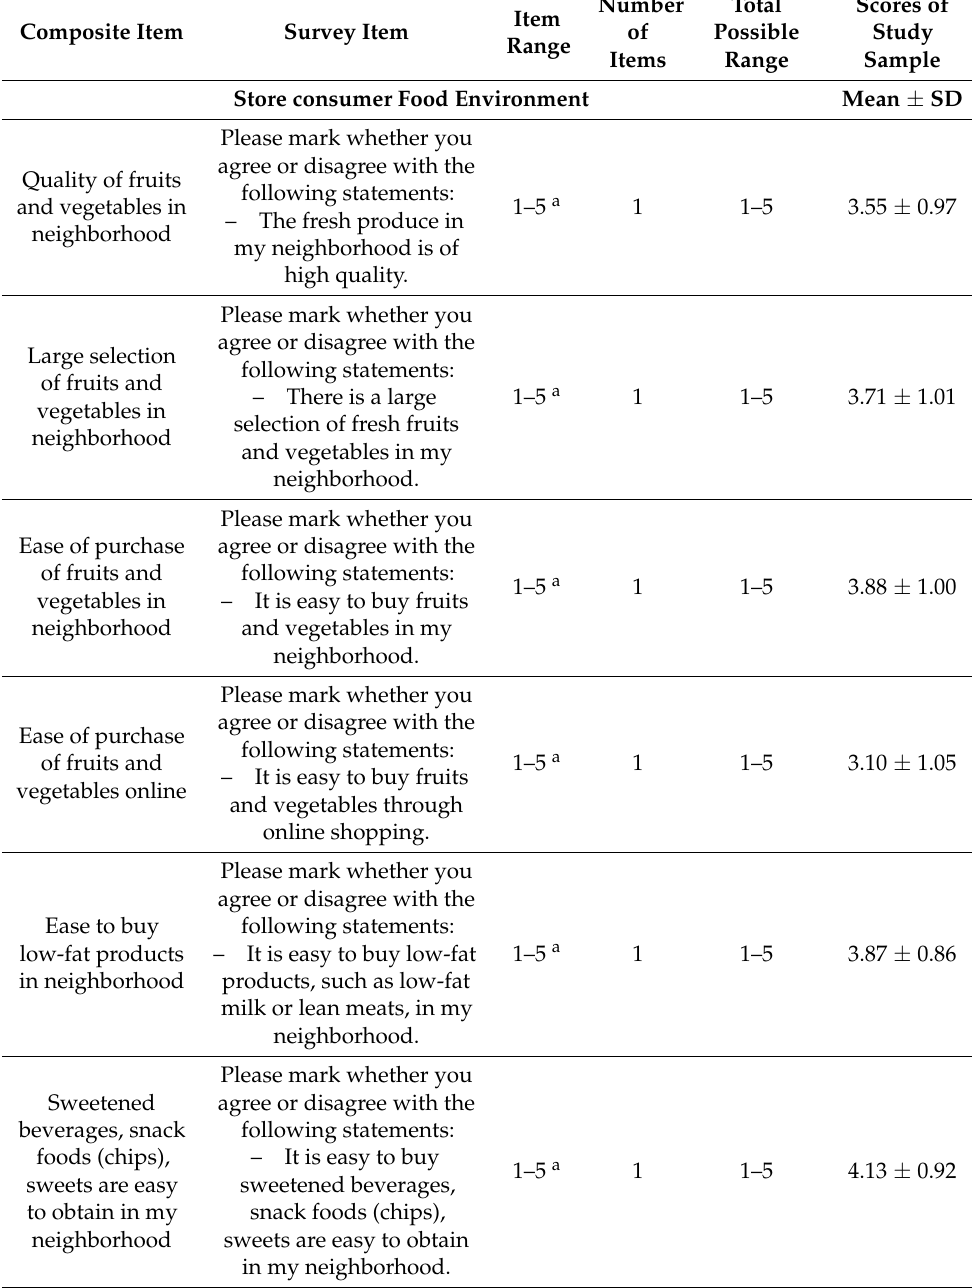
Table 2. Perceived store consumer, community, and home food environments among adults (n = 276) living in a low-income, low food access community in Northeast Connecticut [10,42].